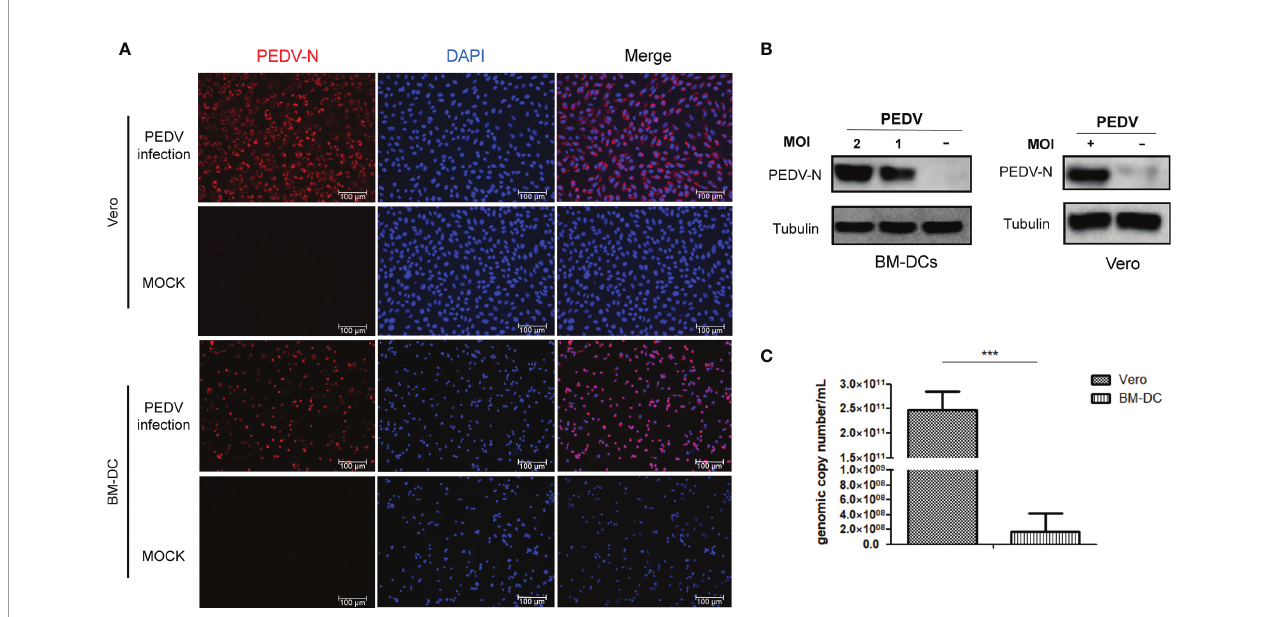
FIGURE 1 | BM-DCs is susceptible for PEDV and supports PEDV replication in vitro . (A) Vero cells and BM-DCs were infected by Vero cell-adapted PEDV strain KB2013-p120 at 1MOI for 24 hours then harvested and subjected with immuno fl uorescence assay using mice serum raised against recombinant PEDV-N protein and visualized by secondary antibodies. Representing IFA images were selected from at least three independent experiments (hereby and thereafter unless speci fi ed). (B) BM-DCs were infected by PEDV-KB2013-p120 strain at 1MOI or 2MOI for 24 hours then harvested for western blot using mice serum raised against recombinant PEDV-N protein. Normal BM-DCs cells without PEDV infection were included as control. The Vero cells infected by PEDV-KB2013-p120 strain at 1MOI for 24 hours then harvested for western blot using mice serum raised against recombinant PEDV-N protein. Normal Vero cells without PEDV infection were included as control. Representing western blot images were selected from at least three independent experiments (hereby and thereafter unless speci fi ed). (C) BM-DCs and Vero cells were infected by PEDV-KB2013-p120 strain at 1MOI for 24 hours then harvested by TRizol for absolute quanti fi cation of PEDV viral RNA copies using qPCR. Error bars represent variation from at least three independent experiments. Signi fi cant differences between indicated groups was marked by *** P <